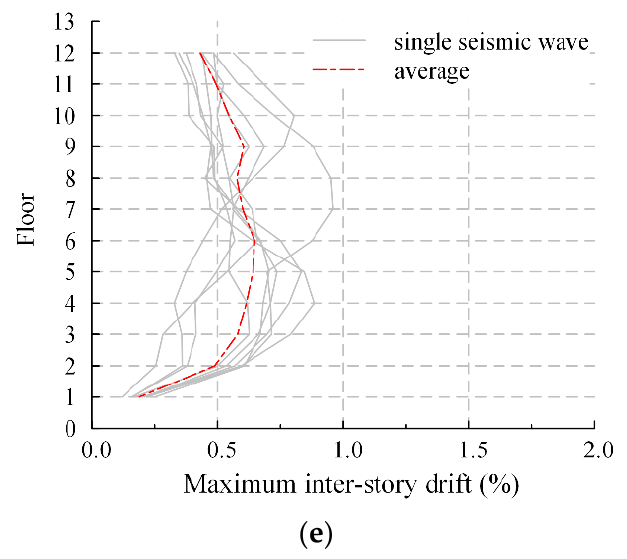
Figure 18. Maximum inter-story drift response of the 12-story PCF-BRB structure: ( a ) modal12-3.0; ( b ) modal12-4.0; ( c ) modal12-5.0; ( d ) modal12-6.0; and ( e ) modal12-7.0.